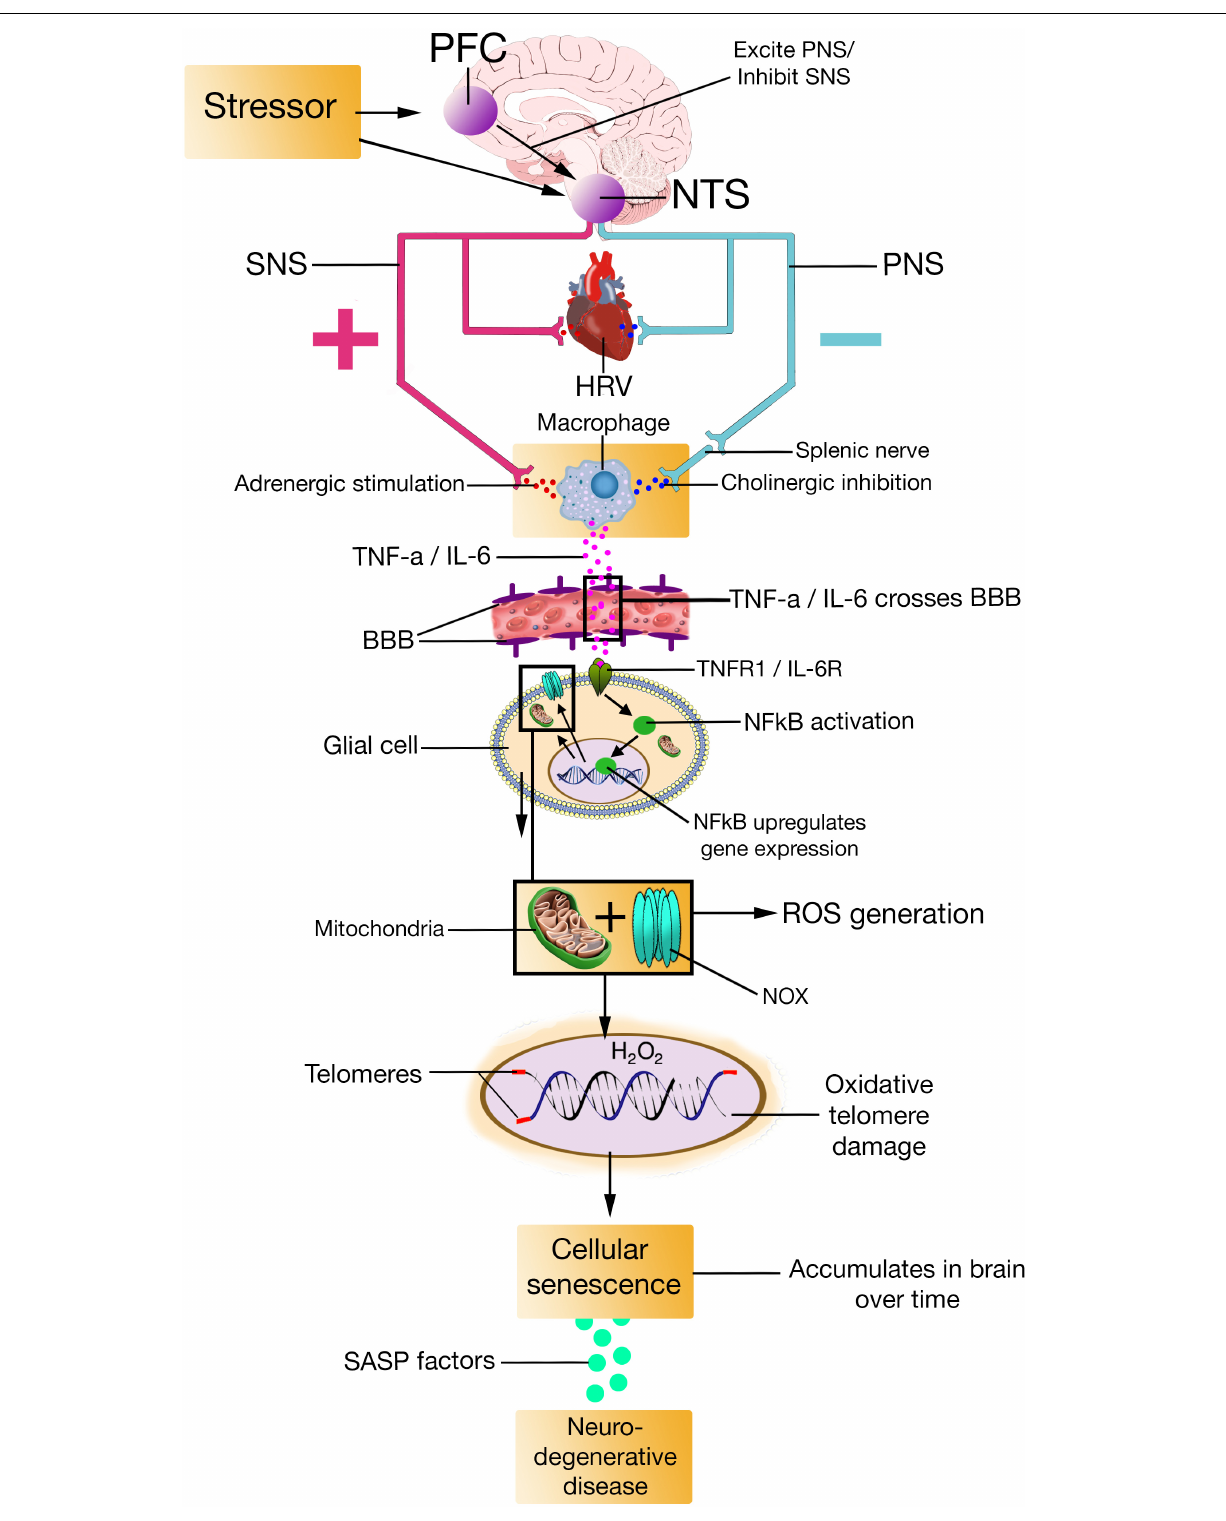
Frontiers in Neuroscience |